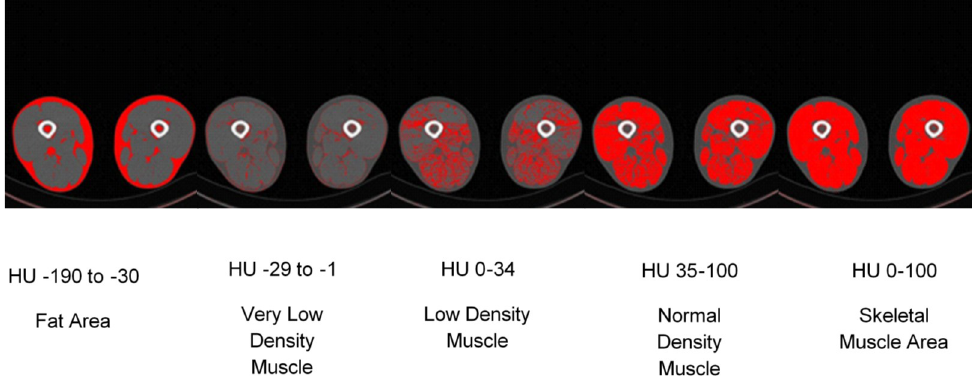
Fig 1. Graphical representation of various Hounsfield Unit ranges used for determining fat and skeletal muscle. Visual output from Image J when assessing fat area, very low density muscle (VLDM), low density muscle (LDM), normal density muscle (NDM), and skeletal muscle area